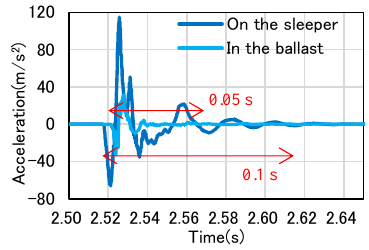
Figure 8. Example of the time-history waveform of the vertical acceleration on the ladder sleepers and in the ballast.